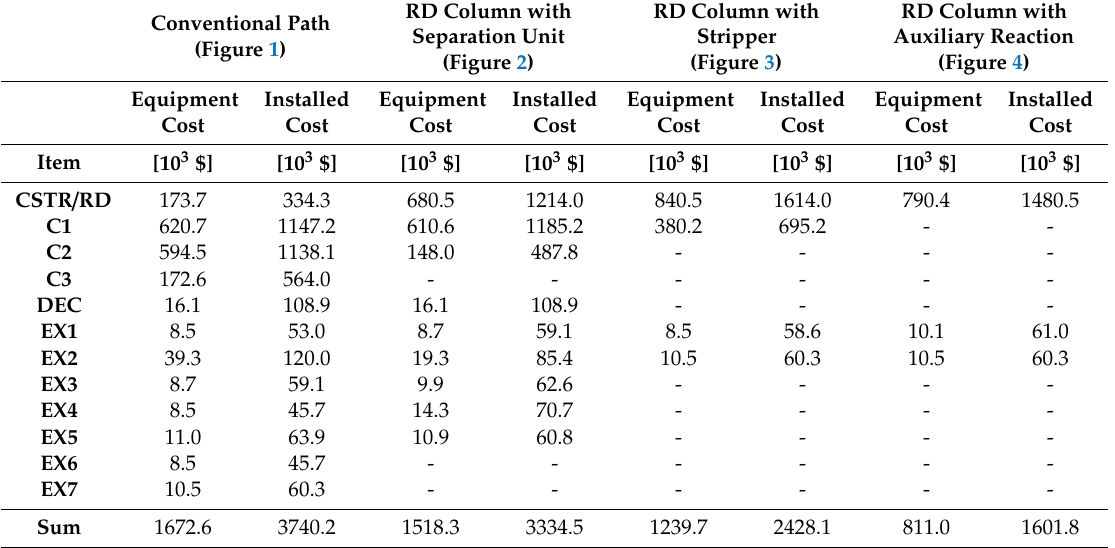
Table A1. Equipment cost and total installed cost of individual